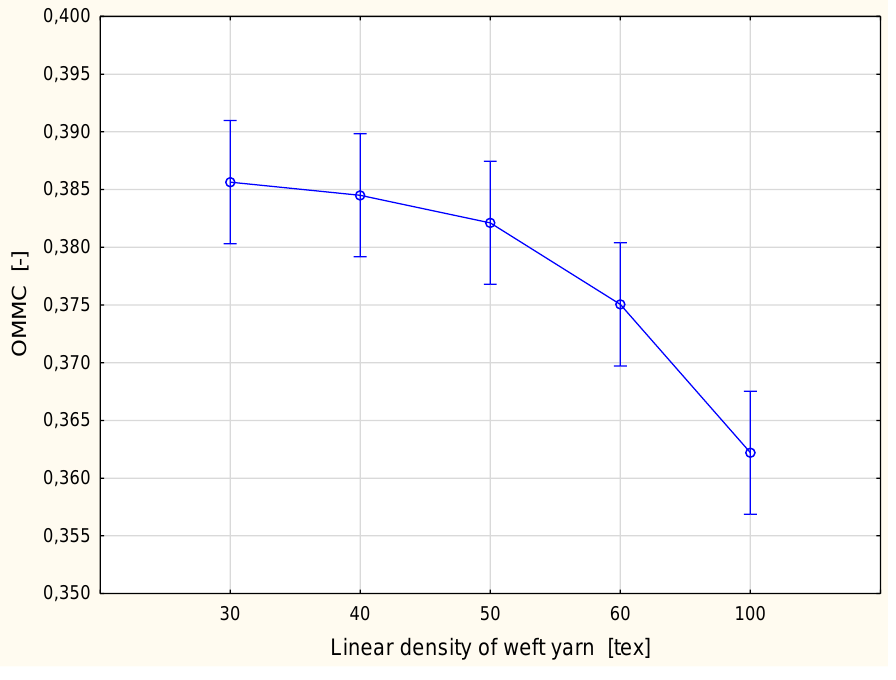
Figure 15. Overall moisture management capacity vs. linear density of the weft yarn. Due to the fact that the null hypothesis (assuming equality of the mean values of individual parameters for the tested variants of fabrics) was rejected, an analysis of the significance of differences between the individual means was performed using Tukey’s test. The Tukey ’ s test results for individual parameters are presented in the tables below (Tables 5 – 14). In the tables, statistically significant differences are marked in italics and bold. Table 5. The results of the Tukey’s test for the WTT.